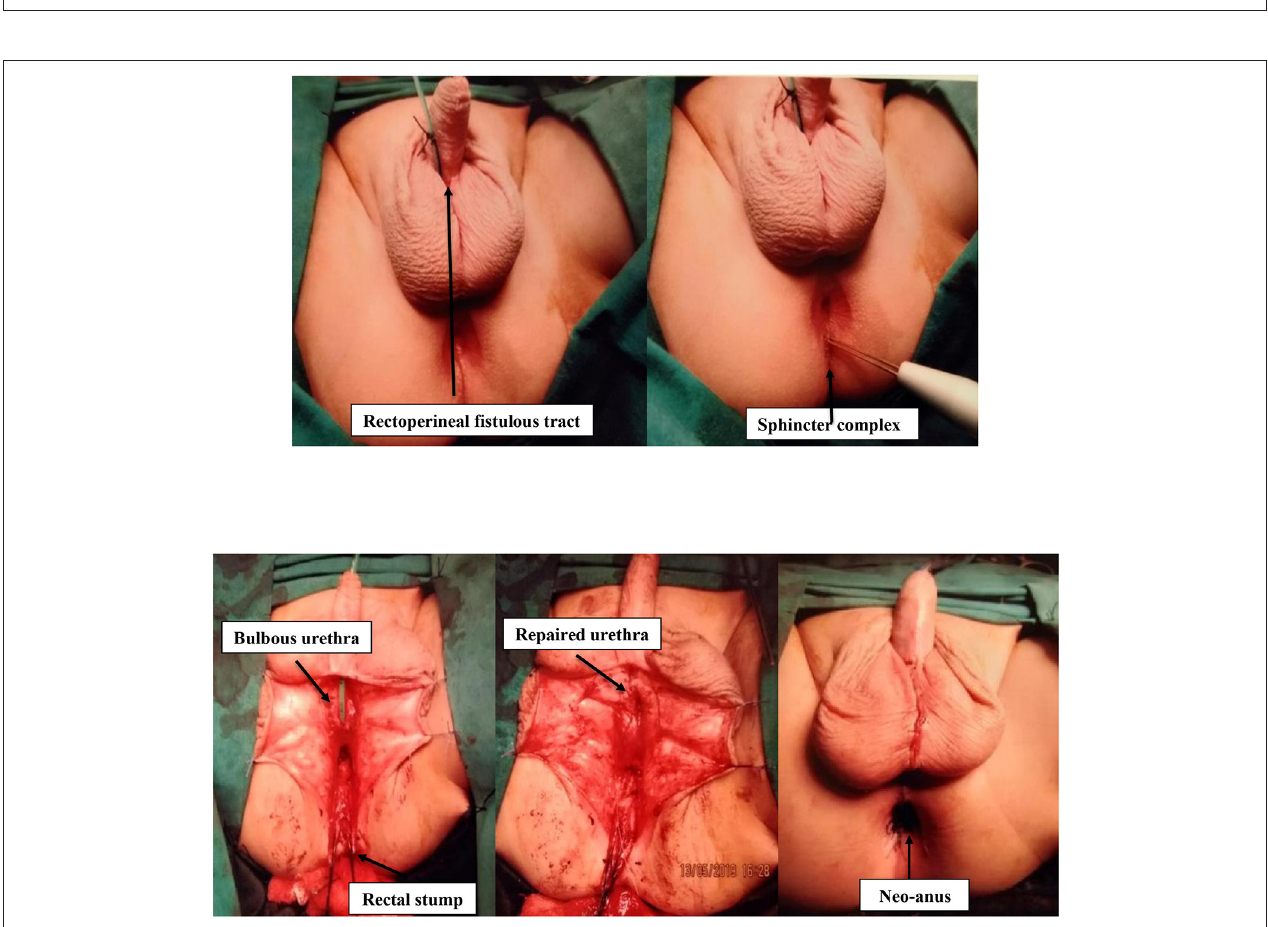
Frontiers in Surgery | www.frontiersin.org